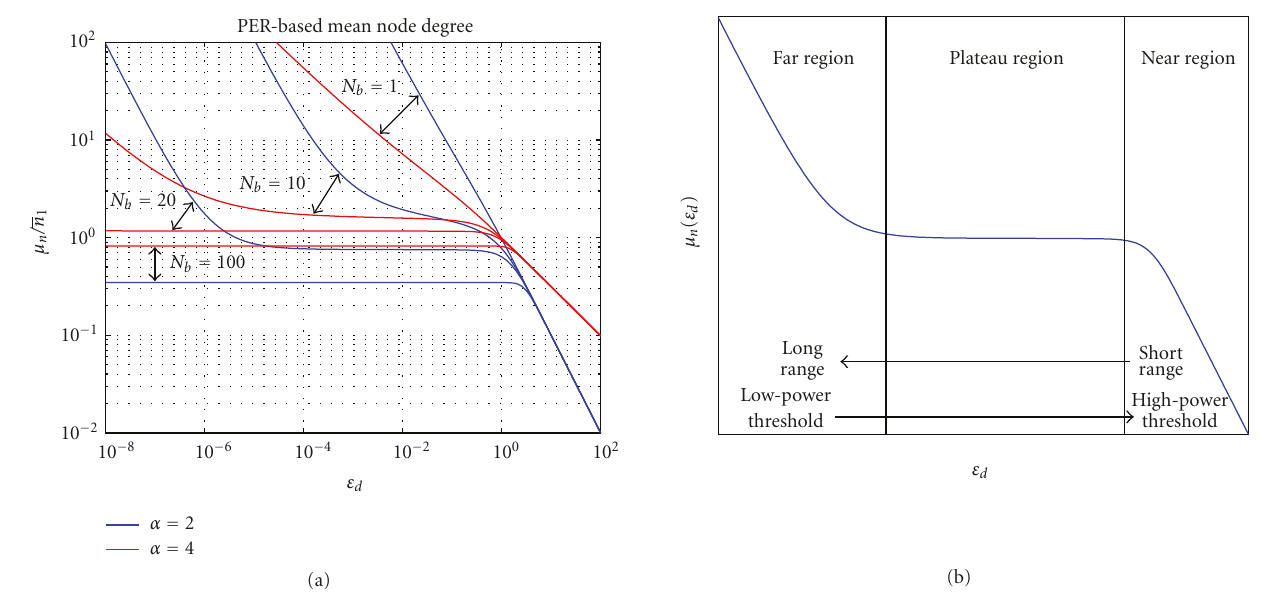
Figure 4: The curves represent the mean node degree as a function of the power detection level ( ε d ) for α = 2 (blue) and α = 4 (red dashed). Each curve can be divided into three sections as illustrated in (b). Reading the chart from right to left, we have (i) the near section (high SNR threshold, low range), where the connectivity gets higher the less power threshold is used because the more range is achieved; (ii) the middle section where the curves reach a plateau. At this distance, the probability of having a new neighbor is negligible. Keeping N b fixed, the plateau is reached whatever α is, approximately at the same SNR threshold, but stretches to a lower value for higher α ; (iii) the far section (low SNR threshold, high range) for which the mean node degree diverges, having ε d → 0. At such a distance, the successful transmission probability decreases more slowly than the number of nodes grows. Basically, for a useful packet size ( Nb > 20), the divergence region still mathematically exists but moves towards very low SNR